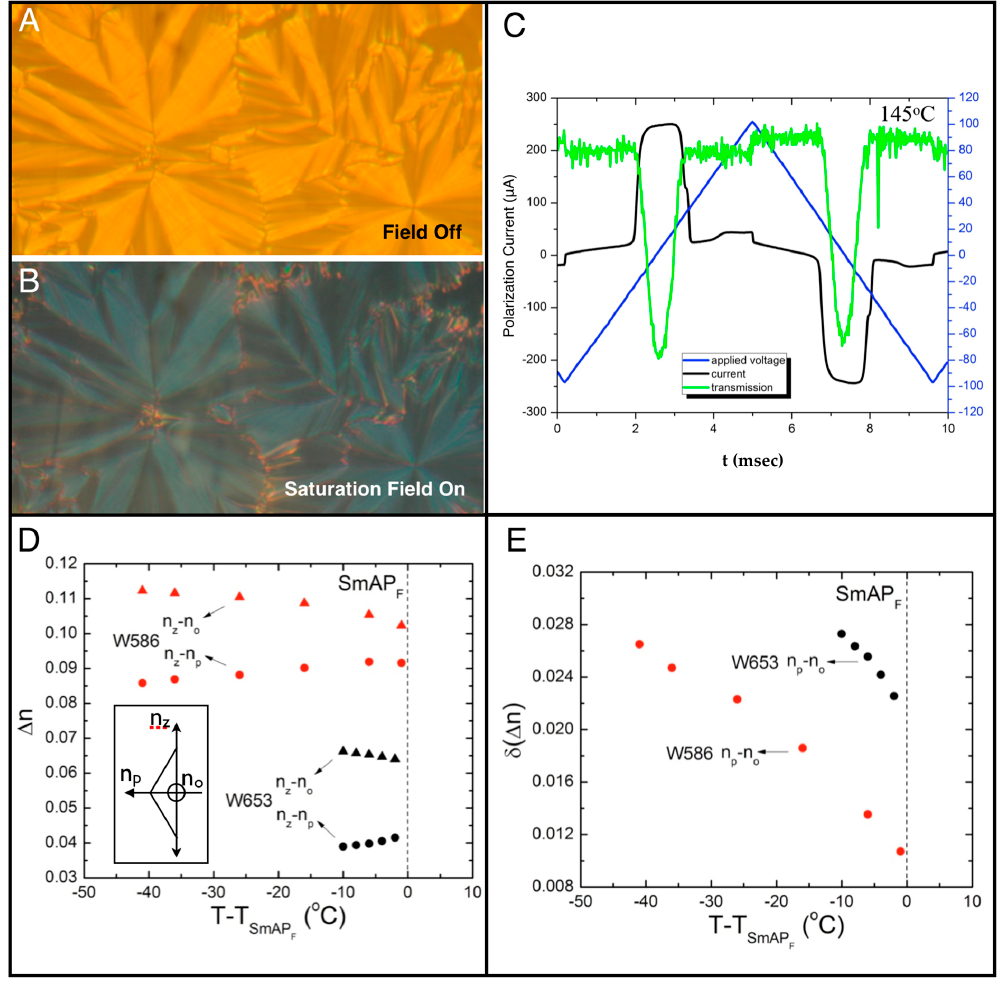
Figure 4. ( A , B ): Polarized light microscopic images (polarizer and analyzer crossed) of a random planar aligned indium-tin oxide (ITO)-glass cell (T = 140 °C) containing W653 of sample thickness 8 µm, and rubbed polyimide (PI) insulating layers. As for W586 , the rubbed PI gives random planar alignment of the smectic, but provides the dielectric behavior necessary for V-shaped switching. The SmAP F phase of W653 shows typical focal conic textures without field, and with an applied field at saturation. The field-on state shows the expected increase in ∆ n; ( C ): Electrooptics of the SmAP F phase, showing a flat current response and “V-shaped” transmission response to a voltage ramp. The green curves indicate transmission, with a minimum value close to zero. These are the defining characteristics of electrostatic V-shaped switching; ( D , E ): ∆ n and δ∆ n, as a of function of applied field (E = 0 and E > saturation) and temperature for W586 , and W653 .